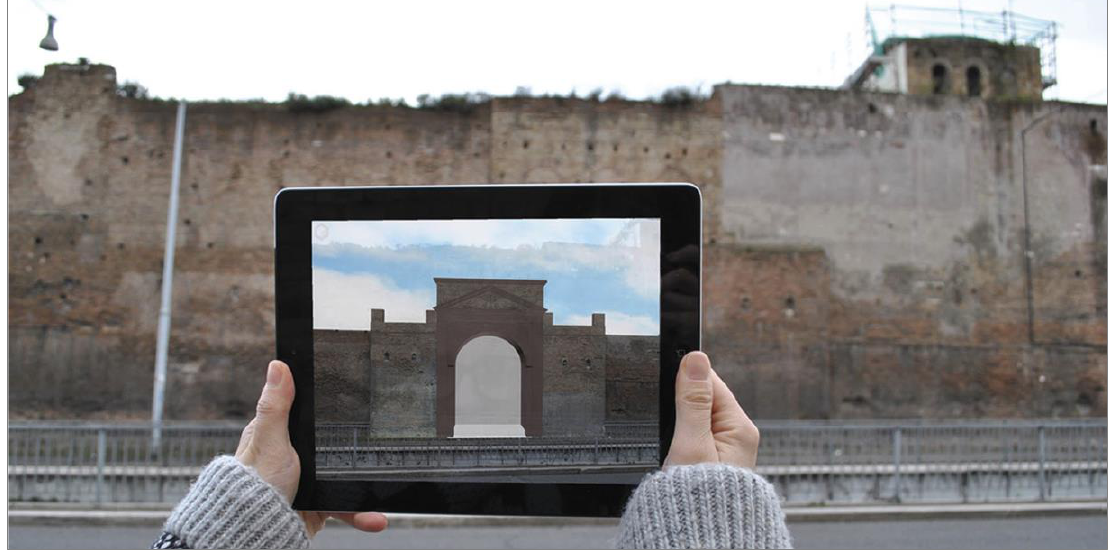
Figure 5 Early Examples of Mobile AR (Canciani & Saccone,